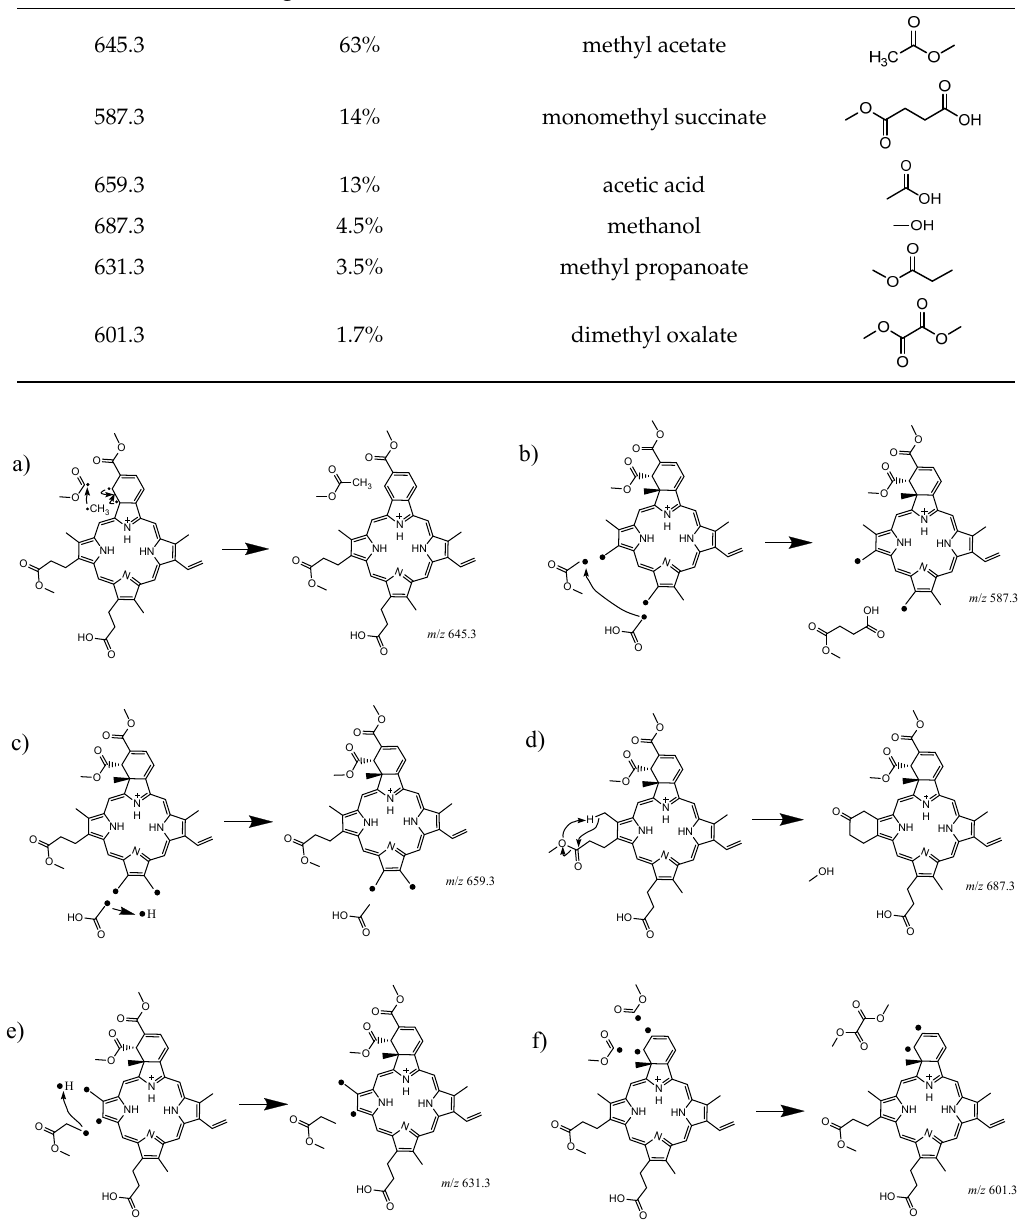
Figure 2. Proposed CID dissociation pathways associated with the peaks corresponding to ( a ) the major fragment observed at m / z 645.3 (63% abundancy), ( b ) the fragment at m / z 587.3 (14%), ( c ) the fragment at m / z 659.3 (13%), ( d ) the fragment at m / z 687.3 (4.5%), ( e ) the fragment at m / z 631.3 (3.5%), and ( f ) the fragment at m / z 601.3 (1.7%).